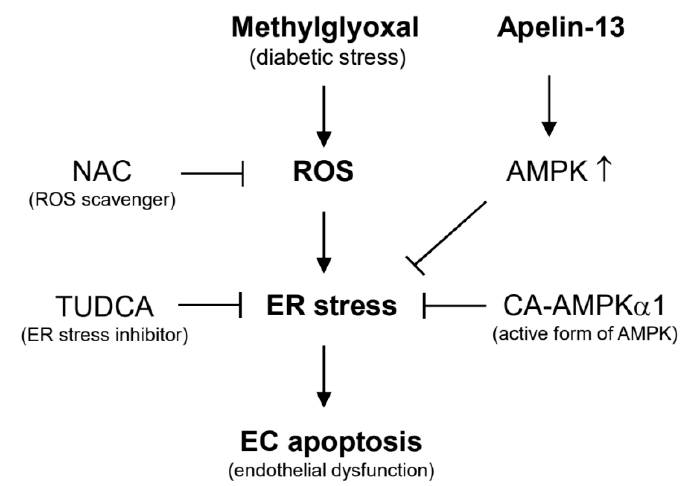
Figure 6. Molecular mechanisms involved in the protective effects of apelin-13 against methylglyoxal-induced endothelial dysfunction. NAC (ROS inhibitor) and TUDCA (ER stress inhibitor) inhibit MGO-induced ER stress and endothelial apoptosis. The activation of AMPK might be involved in the protective effects of apelin-13 against MGO-induced endothelial dysfunction.